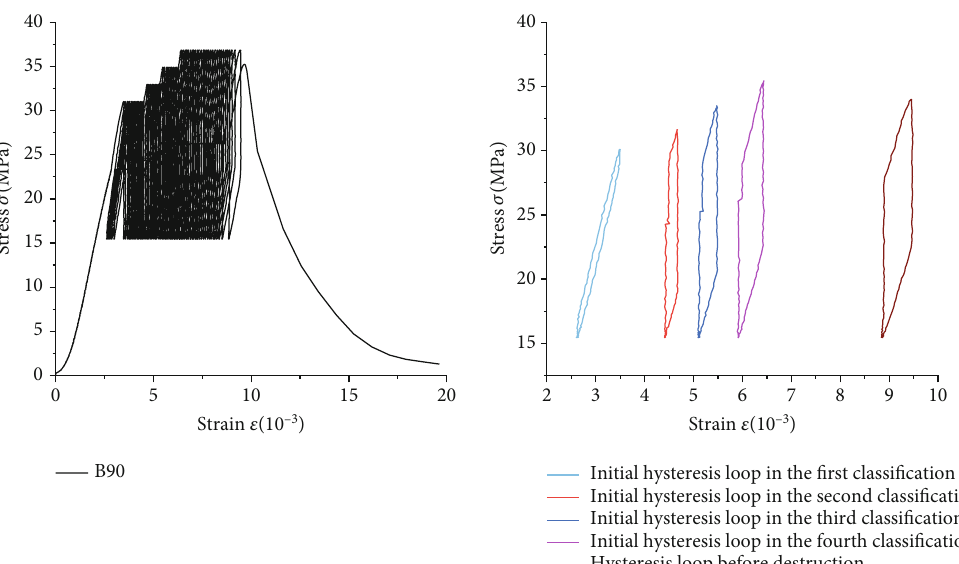
Figure 9: Comparison diagram of stress – strain curve and hysteresis loop for sample B90.